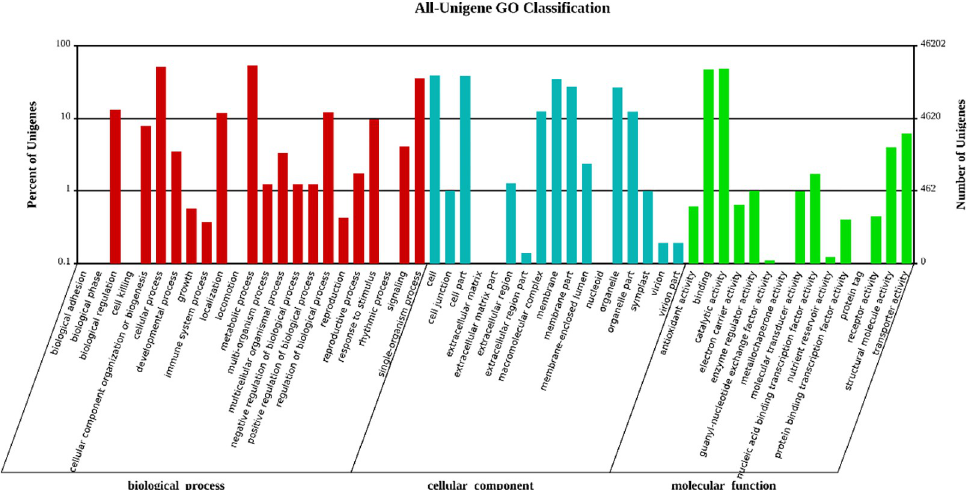
Fig 5. GO classification map. The abscissa is the GO term for the next level of the three major categories in GO, and the ordinate is the number of genes annotated to a term (including the subterm of the term). The three different categories represent the three basic tree classifications for GO terms (from left to right, biological processes, cellular components, molecular functions).